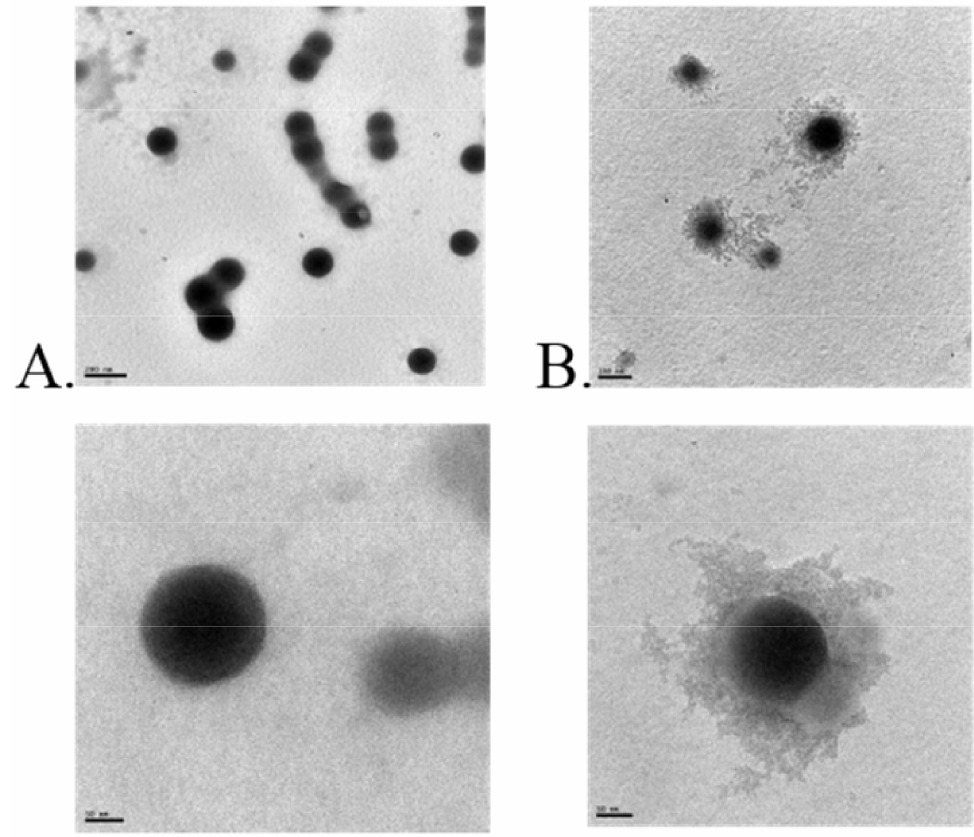
Figure 5. Transmission electron microscopic images of zein-casein ( A ) and zein-lactoferrin ( B ) nanoparticles. The lower panel shows the individual nanocarriers at a higher resolution (scale bar 50 nm). The scale bar in the upper panel is 200 nm for ZC nanoparticles ( A ) and 100 nm for ZLF nanoparticles ( B ). Reproduced with permission from [46], American Chemical Society,